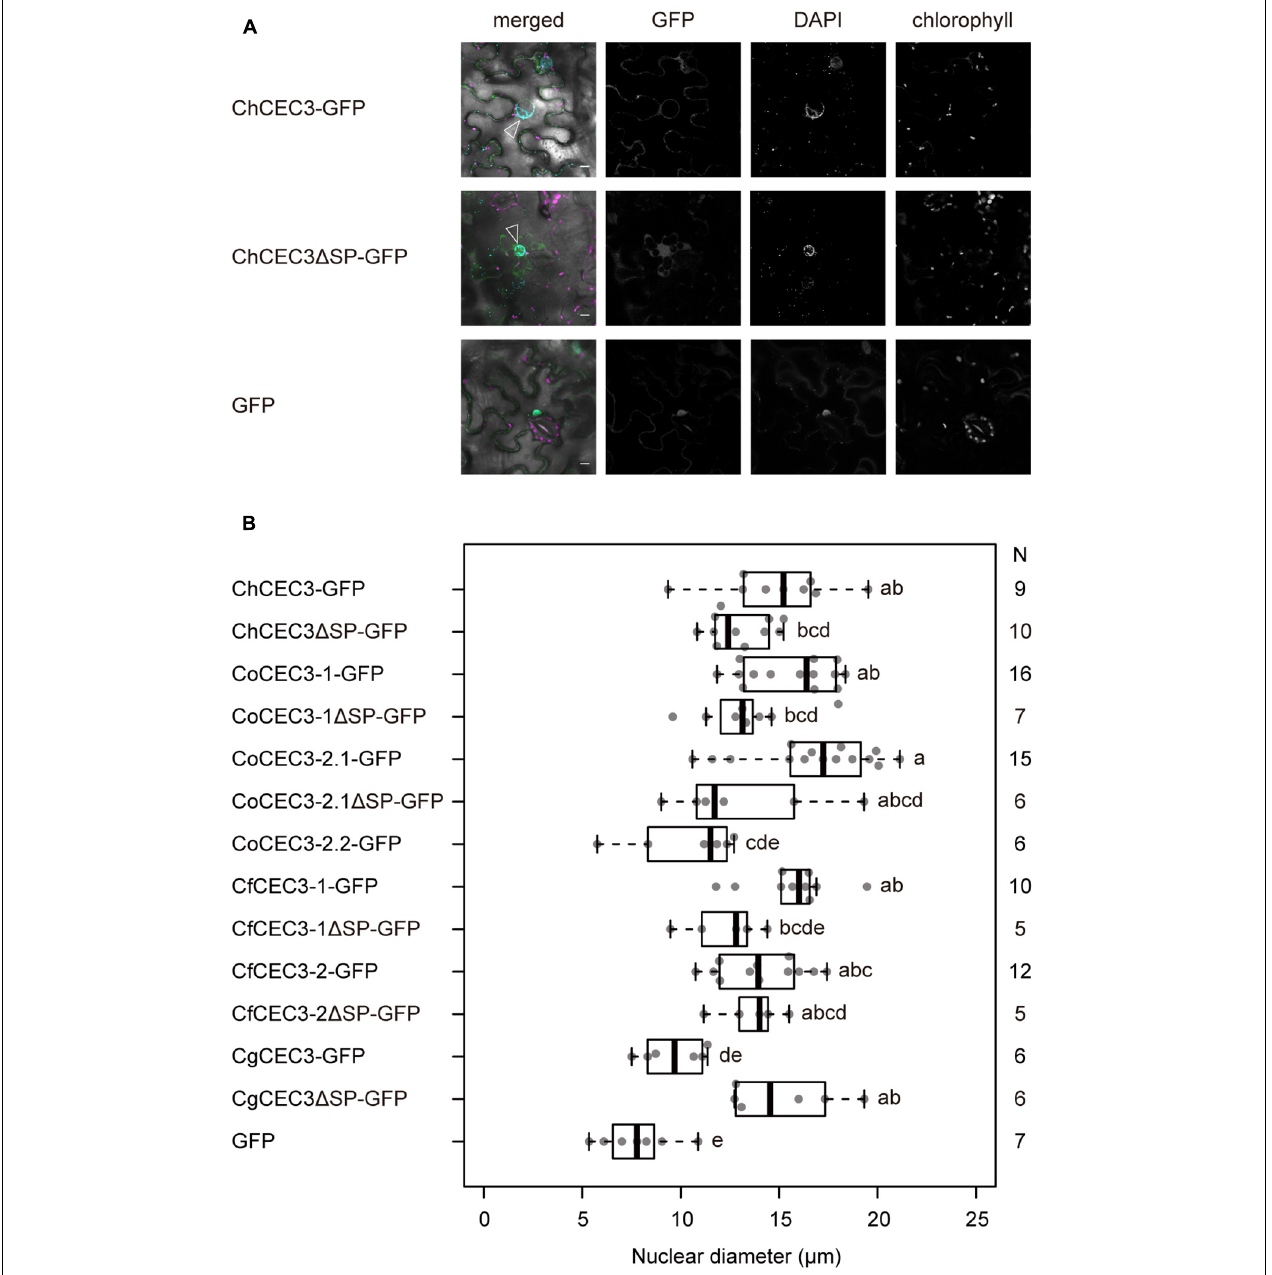
FIGURE 4 | (A) Transient expression of GFP-tagged ChCEC3 protein-induced nuclear expansion in N. benthamiana leaf cells. In merged images, green represents GFP signals, cyan represents DAPI signals, and magenta represents chlorophyll autofluorescence. Open arrowheads indicate expanded nuclei. Images were taken 24 h after infiltration. Bars = 10 µ m. (B) Boxplots of nuclear diameters resulting from transient expression of GFP-tagged CEC3 proteins. Data represent the medians of biological replicates. N represents the number of nuclei examined. CoCEC3-2.2 (cid:49) SP-GFP is not included because no GFP signal was detected. Analysis of variance with Tukey post hoc honestly significant difference test ( P < 0.05) was